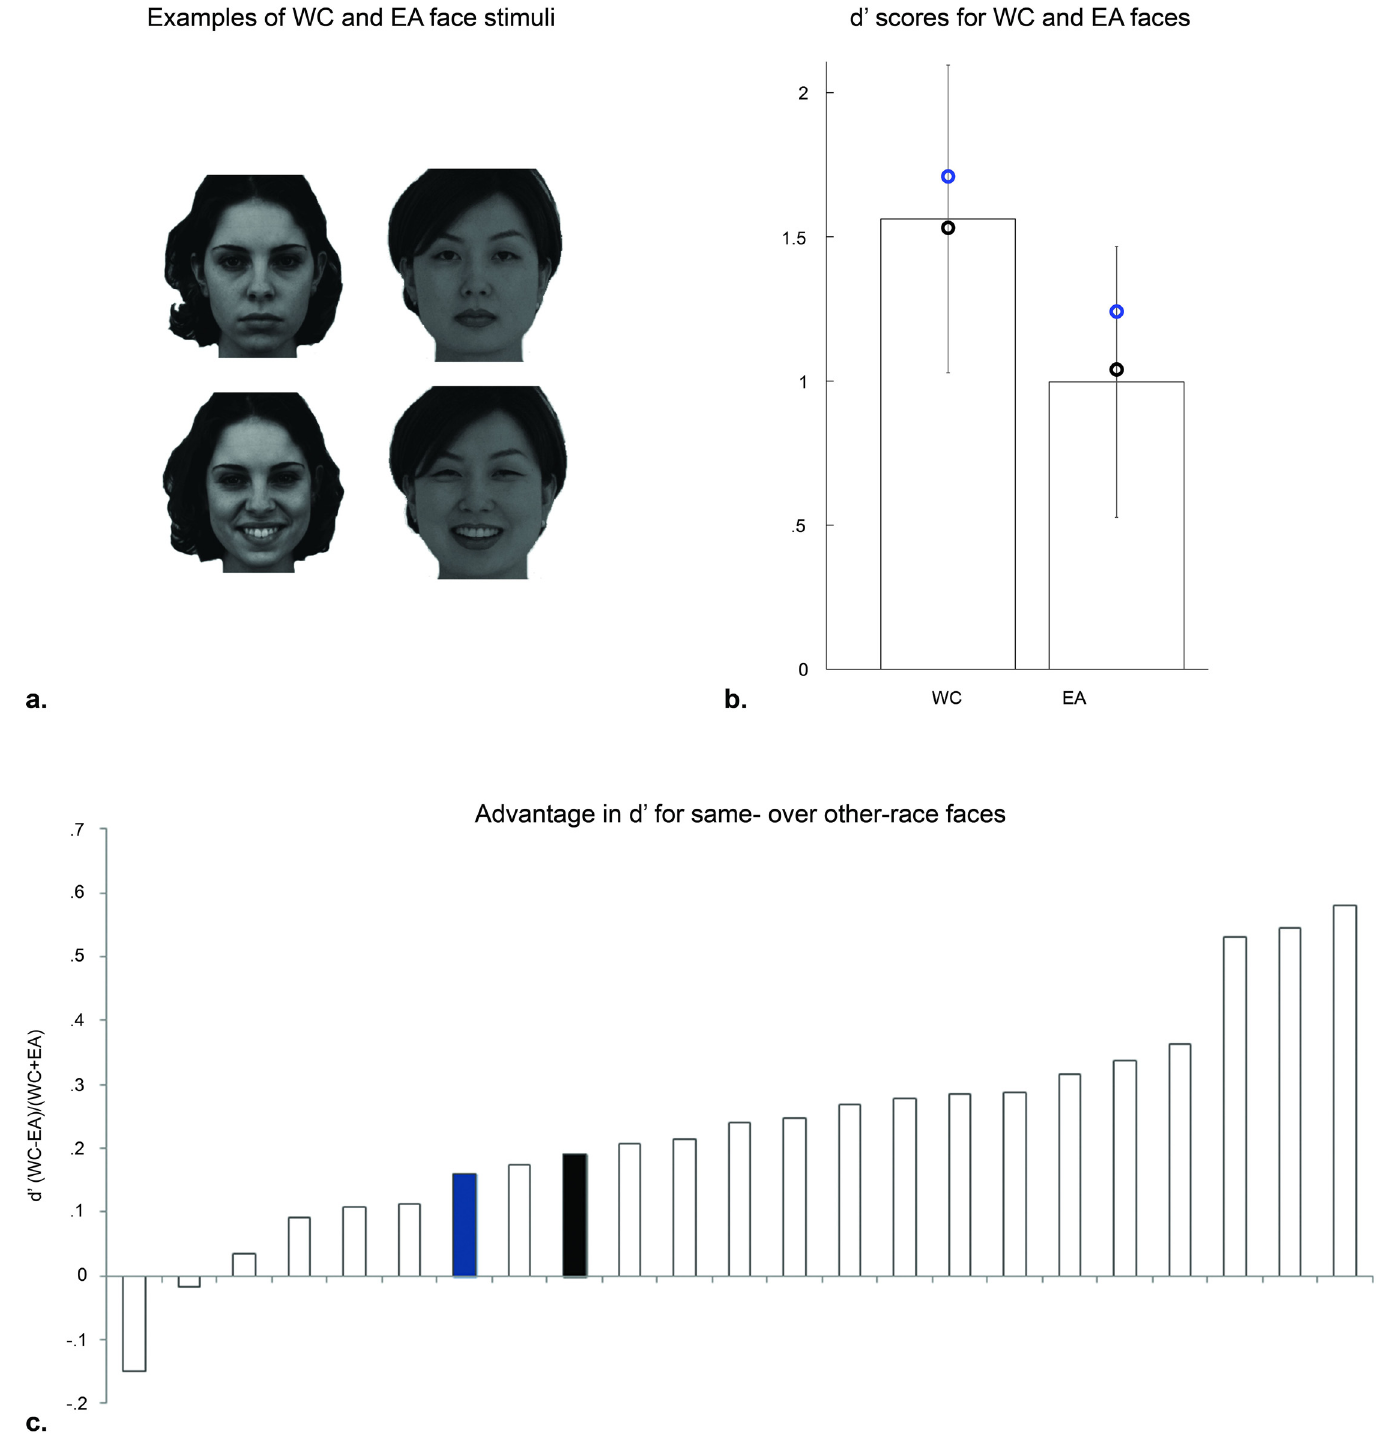
Fig 4. Examples of stimuli and results for Experiment 4: Other-race effect (ORE). a. Examples of stimuli presented. During encoding subjects were presented images of WC and EA identities, which were presented depicting a different facial expression during recognition. b. Controls ’ mean d ’ (bars represent standard errors) per race with SMs ’ scores (SM1: black; SM2: blue) superimposed. c. Individual subjects ’ d ’ advantage for recognition of same- over other-race faces (ranked normalized difference scores). All subjects, including SMs showed superior performance for old/new decisions of own-race